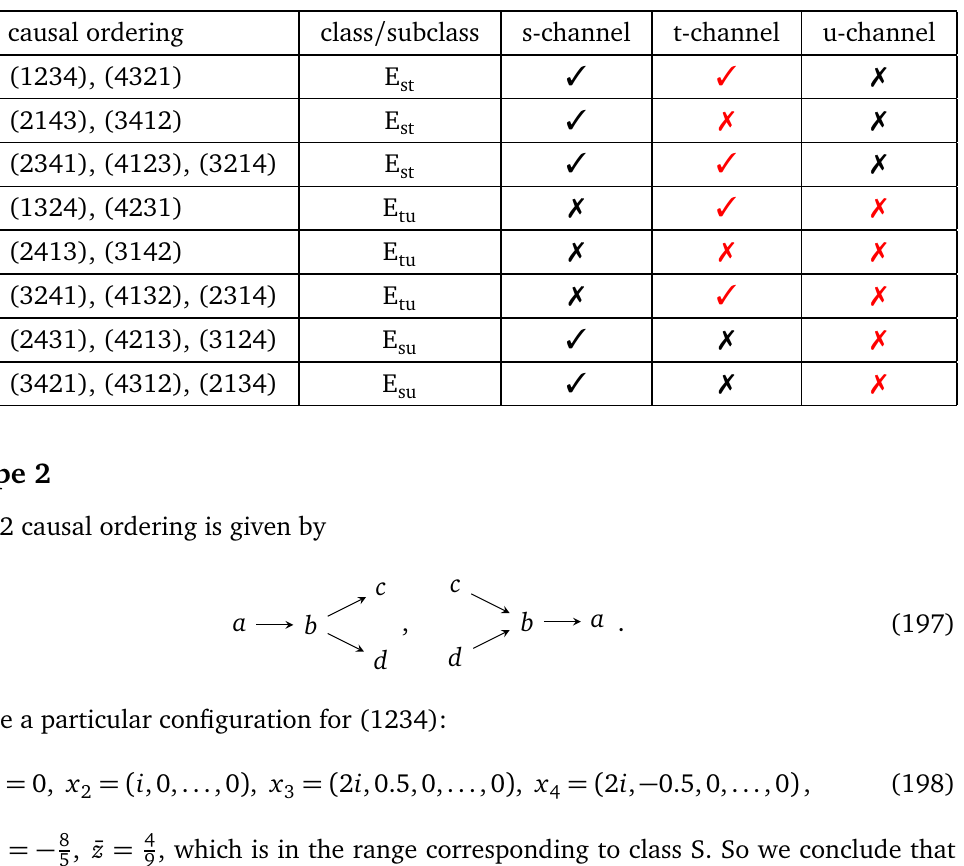
Table 5: OPE convergence properties of type 1 causal orderings